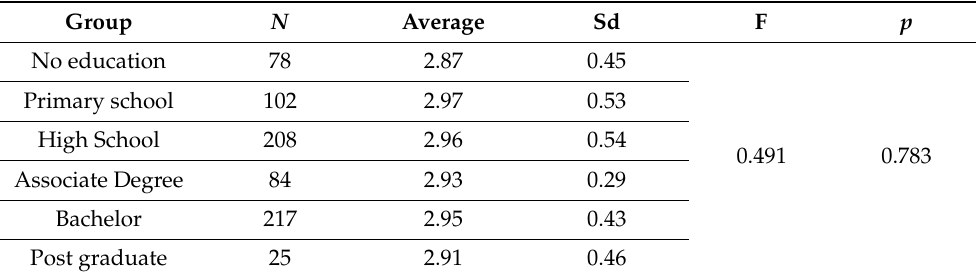
Table 6. Correlations between the opinions of refugees’ on refugee-oriented healthcare services and education